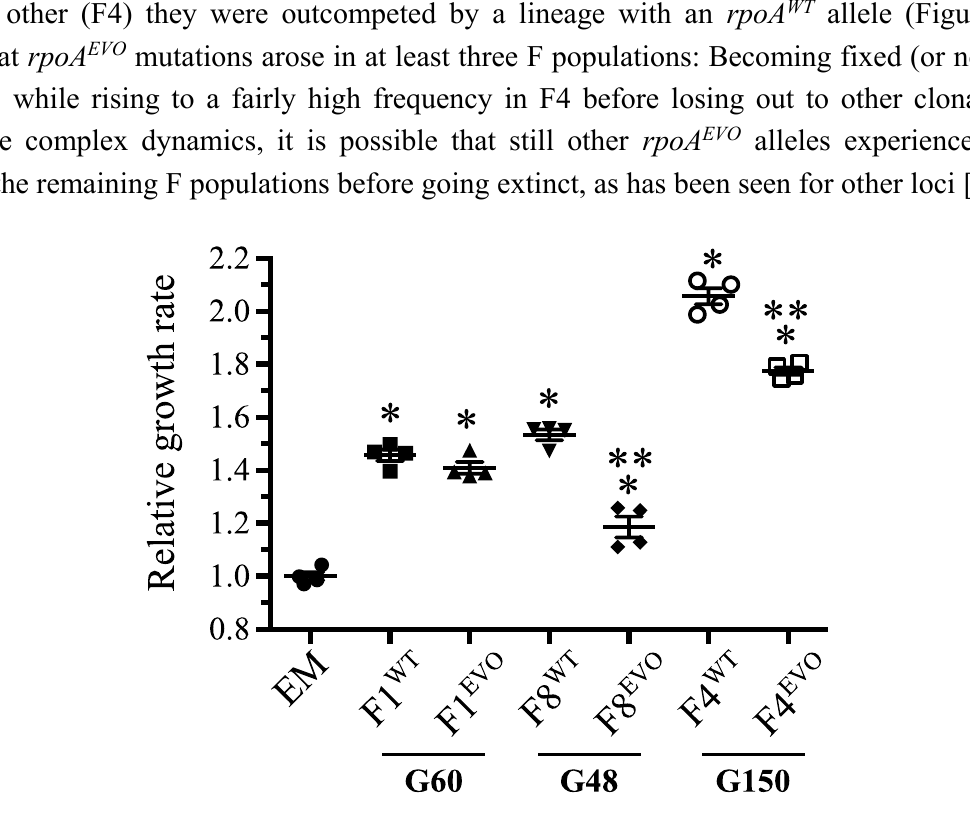
Figure 5. Growth of rpoA EVO and rpoA WT cohorts sampled from early time points of populations F1, F4, and F8. Contemporaneous evolved isolates possessing either rpoA EVO or rpoA WT alleles were isolated from early F populations and assayed for their growth improvements relative to EM on methanol. In all populations, evolved isolates with the rpoA WT clones held a growth advantage over those with rpoA EVO present at the same time point. Single and double asterisks indicate p < 0.05 in a two-tailed, unpaired t test assuming unequal variance in comparing against EM (*) and early isolate cohorts (**),